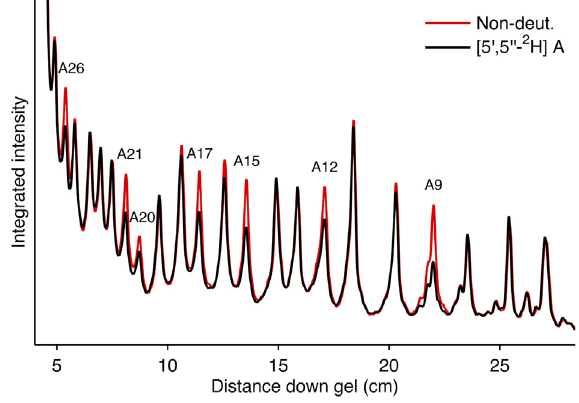
Figure 16. Representative intensity traces from a denaturing polyacrylamide gel on which was separated hydroxyl radical cleavage products of SRL RNA that was synthesized using nondeuterated ATP (red) or [5 ′ ,5 ″ - 2 H]ATP (black). The SRL RNA molecule is 29 nt in length. Labels indicate the positions of adenines in the SRL sequence. A clear difference in band intensity between control and deuterated samples is seen only at adenine residues, because of the deuterium kinetic isotope effect on cleavage by the hydroxyl radical [8].